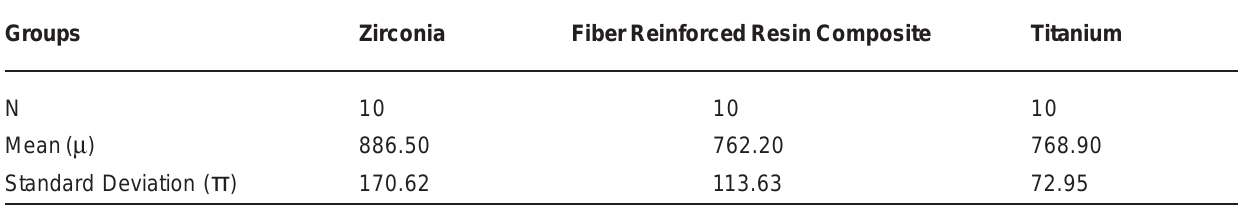
TABLE 1- Mean fracture strength (N) and standard deviation for specimens tested